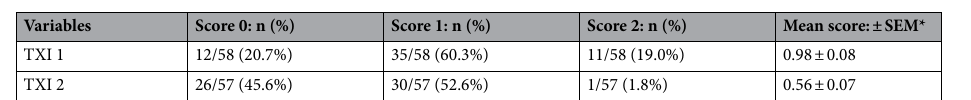
Table 2. The visibility scores rated by the six expert endoscopists by the consensus manner. * P = 0.0003, Statistical analysis was performed using the Student’s t-test. TXI2 could not be performed for one lesion.